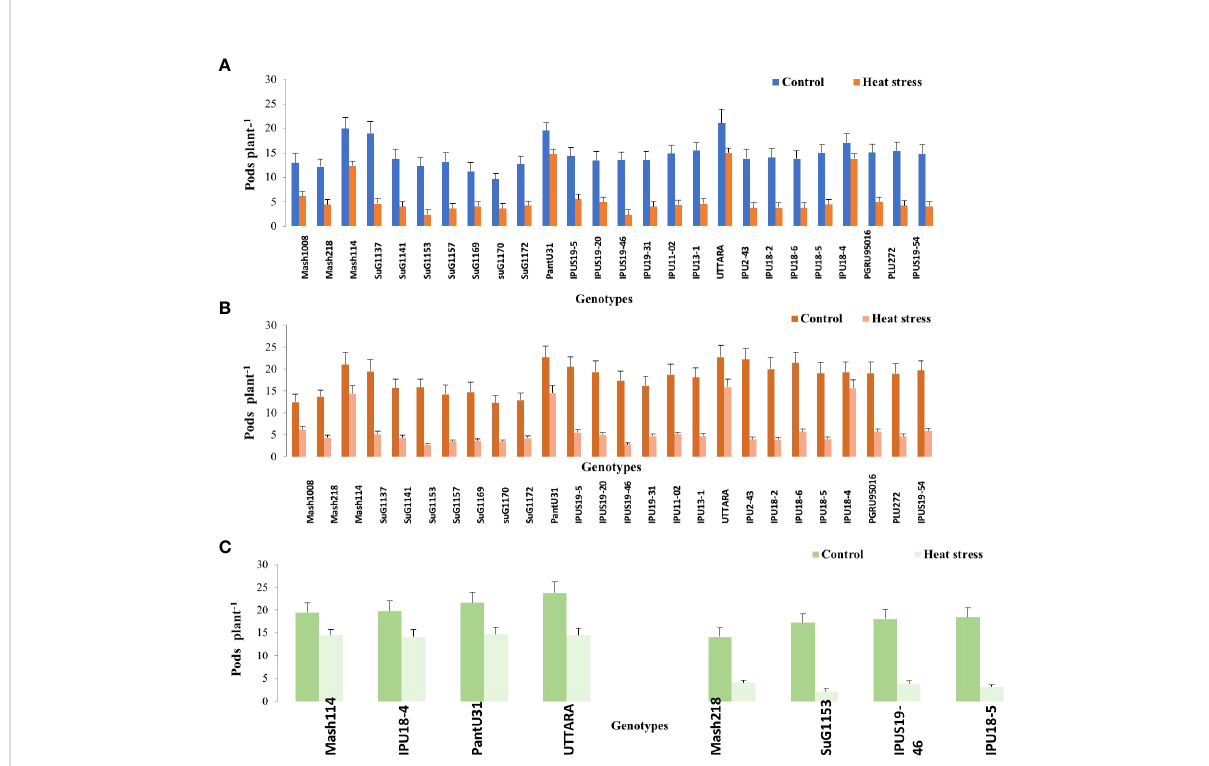
FIGURE 1 Pod number plant -1 of Urdbean genotypes under control (normal-sown; Control) and heat stress environment during 2018 (A) ,2019 (B) and in controlled environment of growth chamber (GC; C ). LSD values (P < 0.05); genotype × treatment: 2.6 (2018), 3.1 (2019), 3.46 (GC). Values are means + SE. (n =